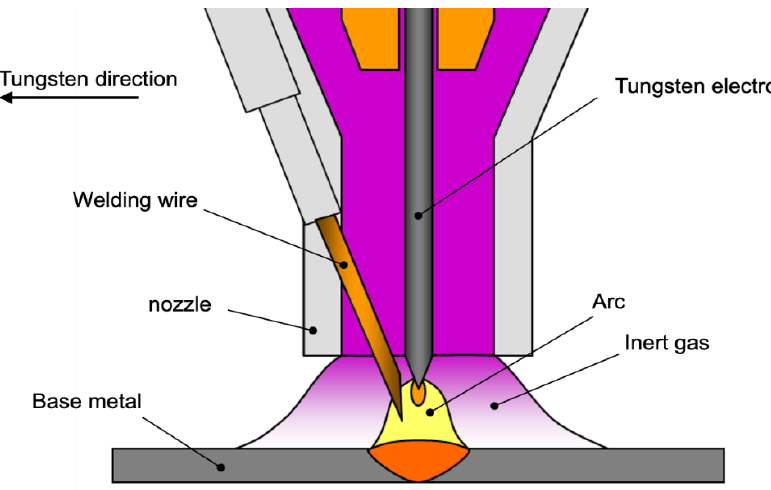
Figure 4. Principle of gas tungsten arc welding (GTAW) surfacing.